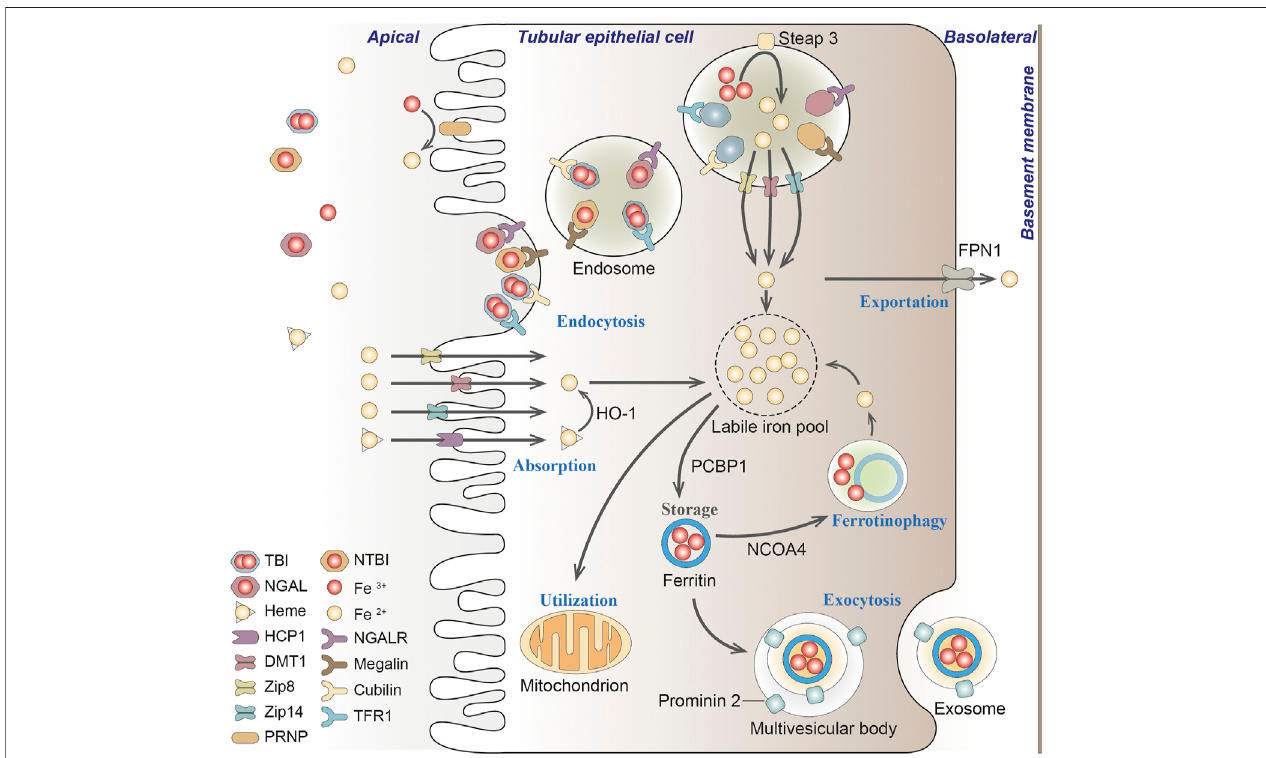
FIGURE 3| Iron transportation in renal tubules. Filtered iron isalmost completelyreabsorbed in renal tubular, where it would be then stored in ferritin, utilized in the mitochondria or exported from the cell. TBI, transferrin-bound iron; NTBI, non-transferrin-bound iron; NGAL, neutrophil gelatinase-associated lipocalin; HO-1, heme oxygenase-1; PCBP1, Poly(rC) binding protein 1; NCOA4, nuclear receptor coactivator 4; FPN1, protein ferroportin 1; HCP1, heme carrier protein 1; DMT1, divalent metal transporter 1; Zip8, zinc transporter ZIP8; Zip14, zinc transporter ZIP14; PRNP, prion protein; NGALR, neutrophil gelatinase-associated lipocalin receptor; TFR1, transferrin receptor